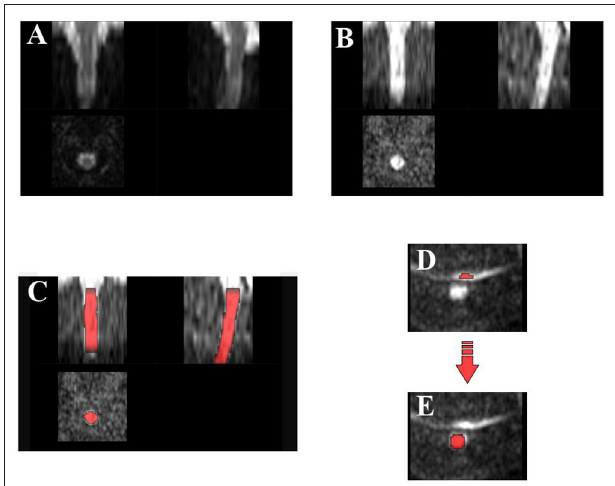
FIGURE 4 | Preprocessing: diffusion kurtosis imaging scan through preprocessing steps for one example subject: (A) field-of-view reduction, (B) motion correction, (C) segmentation: deep learning segmentation algorithm generally achieves satisfactory results in spinal cord detection, (D) example of artifactual slice due to poor fat saturation, causing the fat to alias on the spinal cord area, and (E) requiring manual correction of